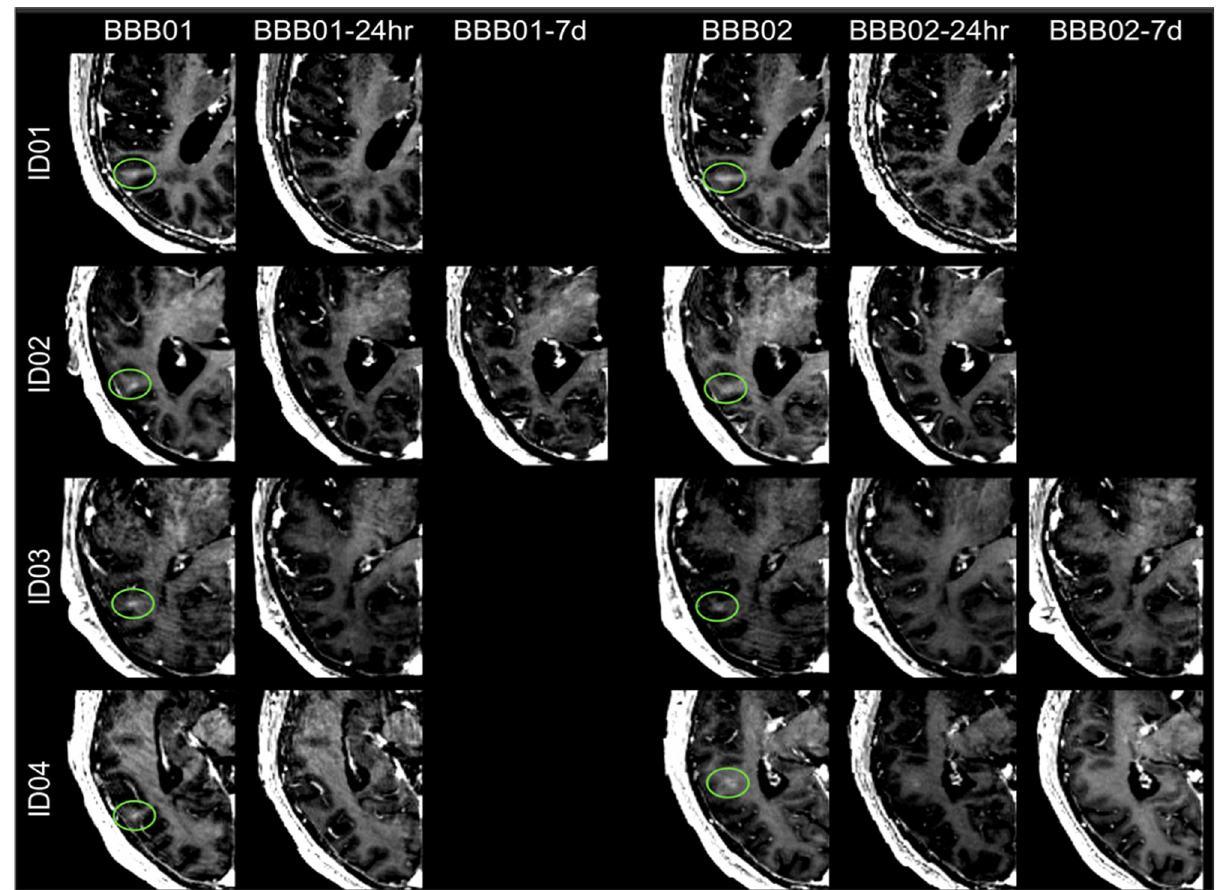
Fig. 3 Gadolinium enhancement in T1-weighted. Immediately after the blood – brain barrier (BBB) opening procedure in patients 1 – 4 (BBB01). The BBB opening was closed after 24 h (stage 1) in patients 1, 3, and 4 (BBB01-24 h) and in patient 2 at the 7th day MR follow-up (BBB01-7d). For stage 2 treatment, BBB was closed in patients 1 and 2 and in the following MRI study in patients 3 and 4